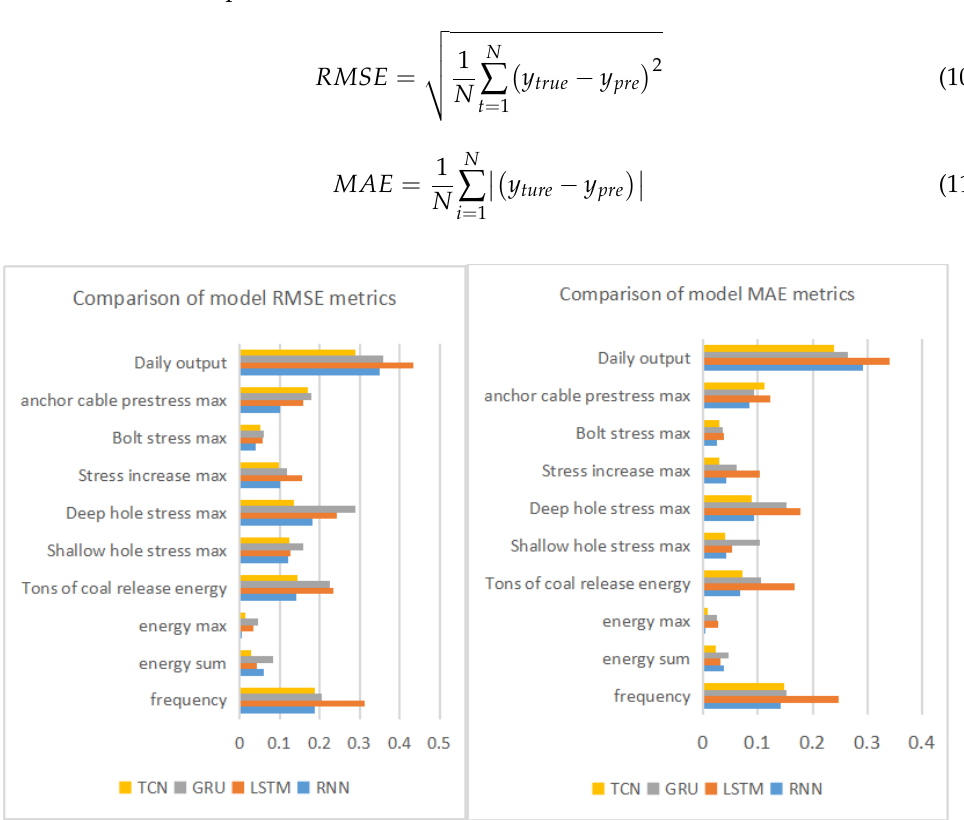
Figure 6. Comparison of the four models’ performance indicators.